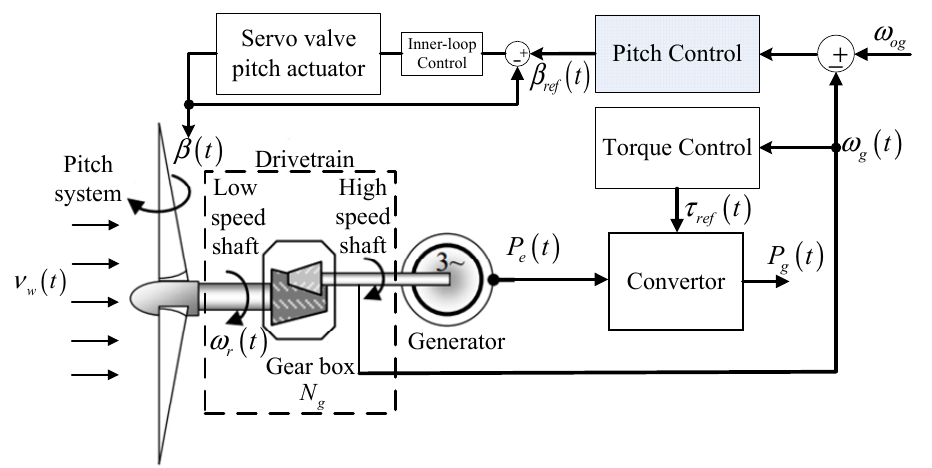
Figure 2. Schematic of a WT with pitch and torque Figure 2. S chematic of a WT with pitch and torque controls.